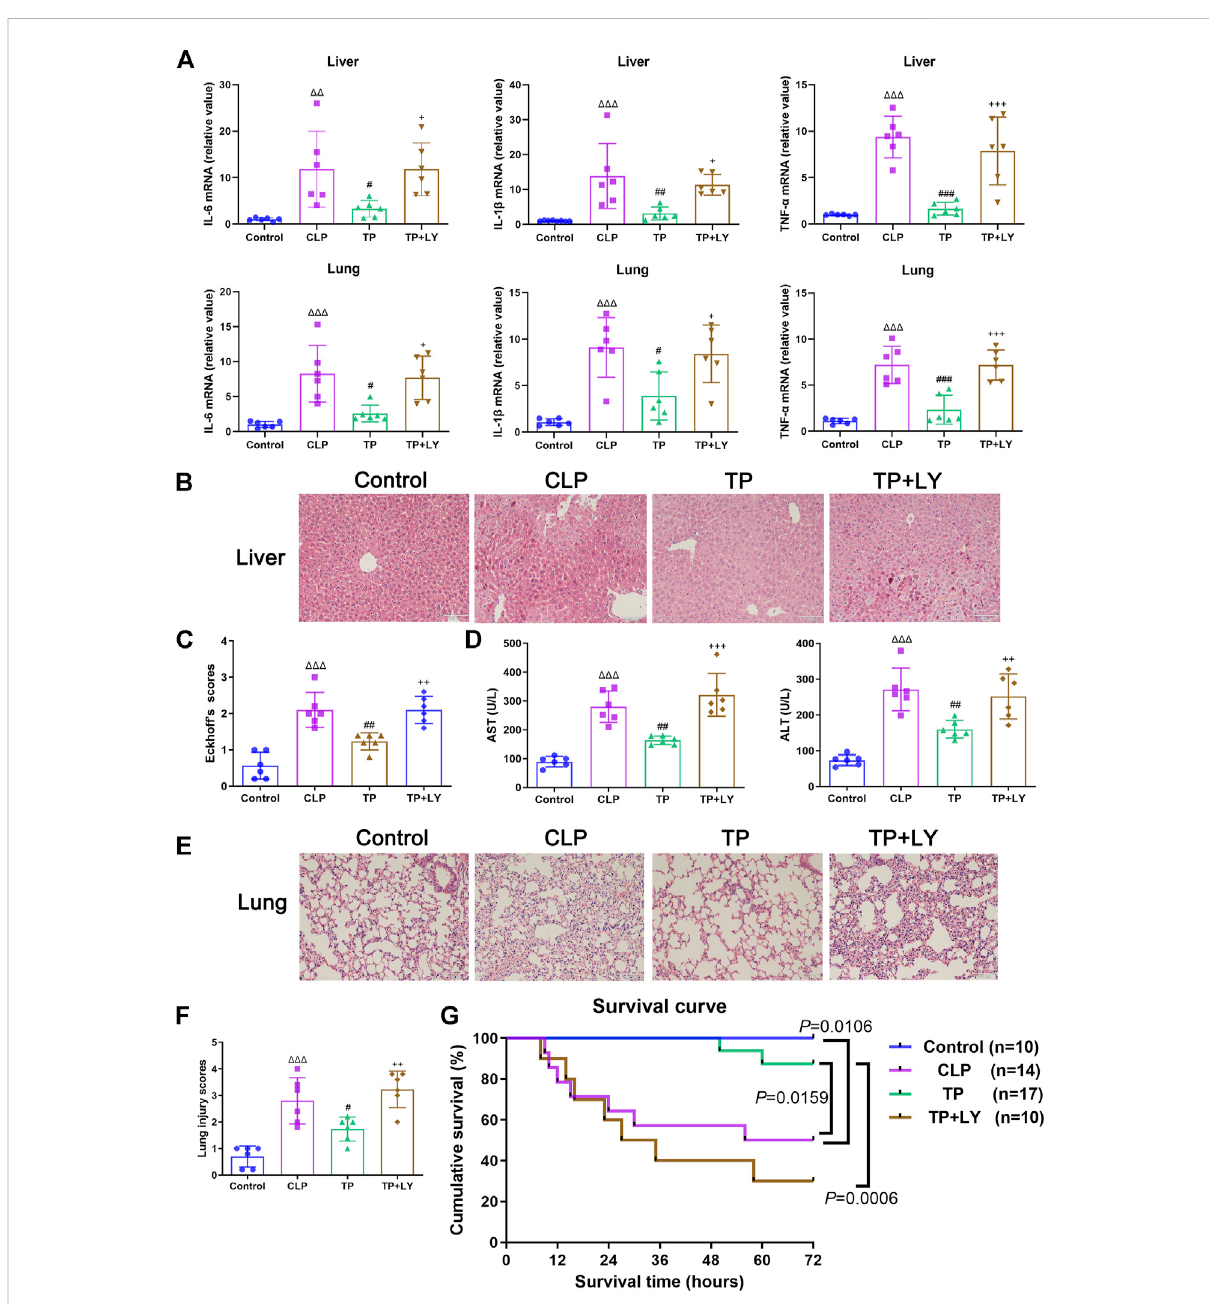
FIGURE 4 Terlipressin reduced organ injuries and improved survival after CLP. (A) IL-6, IL-1 β and TNF- α mRNA levels in liver and lung, n = 6. (B,C) The representative images (×200) and morphological injury scores of liver, n = 6. Scale bars: 100 μ m. (D) AST and ALT levels in serum, n = 6. (E,F) The representative images (×200) and morphological injury scores of lung, n = 6. Scale bars: 100 μ m. Data were expressed by mean ± SD. (G) Survival analysis of different groups. Δ p < 0.05, ΔΔ p < 0.01, ΔΔΔ p < 0.001 vs. Control group. # p < 0.05, ## p < 0.01, ### p < 0.001 vs. CLP group. + p < 0.05, ++ p < 0.01, +++ p < 0.001 vs. TP